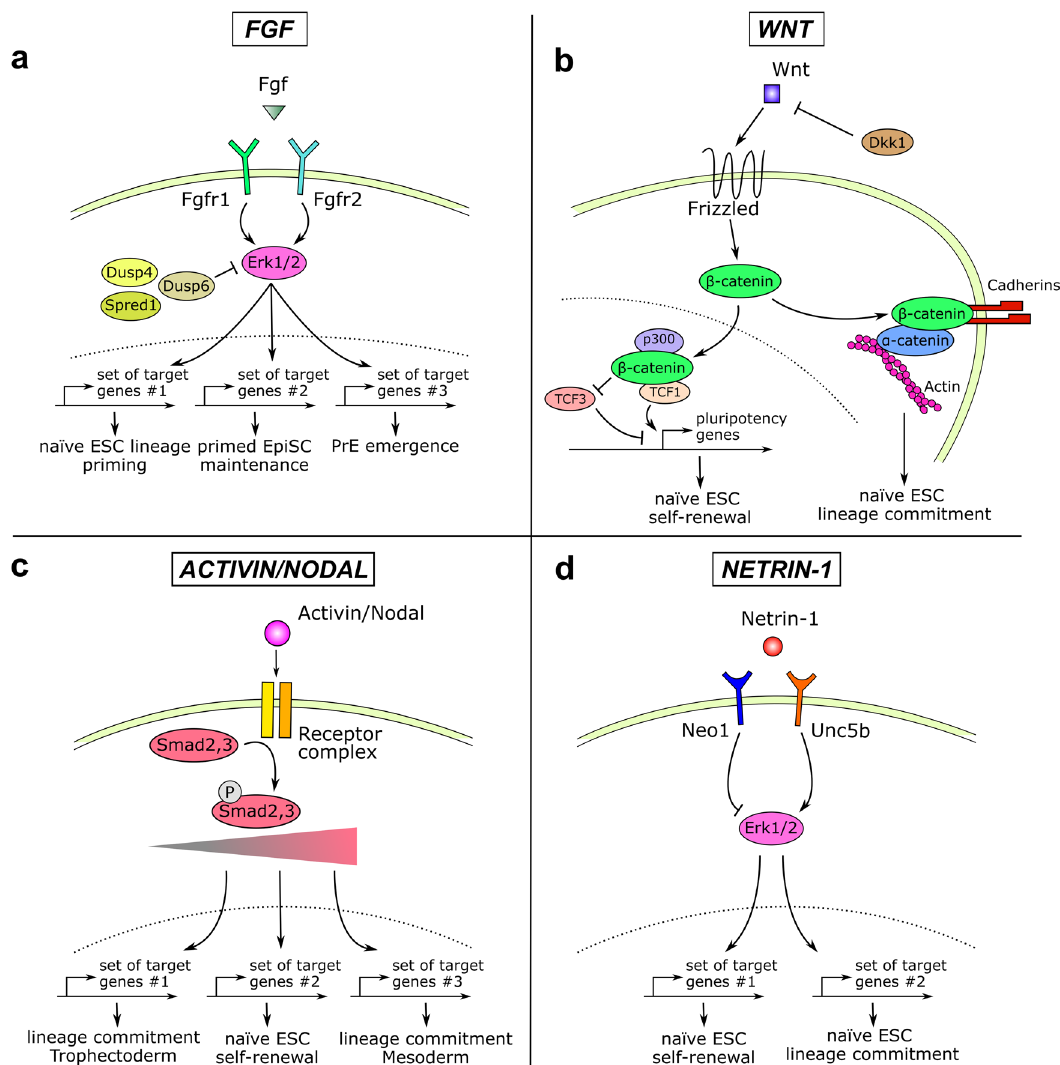
Fig. 2| MolecularVersatility ofsignalling pathways. a FGF/MAPKsignalling. The integration of the FGF signal is modulated by the differential expression of the FGFR1 and FGFR2 receptors. Such integration will lead to various degrees of ERK1/2 activation that will subsequently activate different sets of target genes. b Wnt signalling. The activationof the pathwaywillpromote stemcellself-renewal or lineage commitment. These versatile effects are related to the bifunctional activity of β -catenin in the nucleus and in the cytoplasm. It has to be noted that TCF1 and TCF3 also behave antagonistically on pluripotency genes and ESC